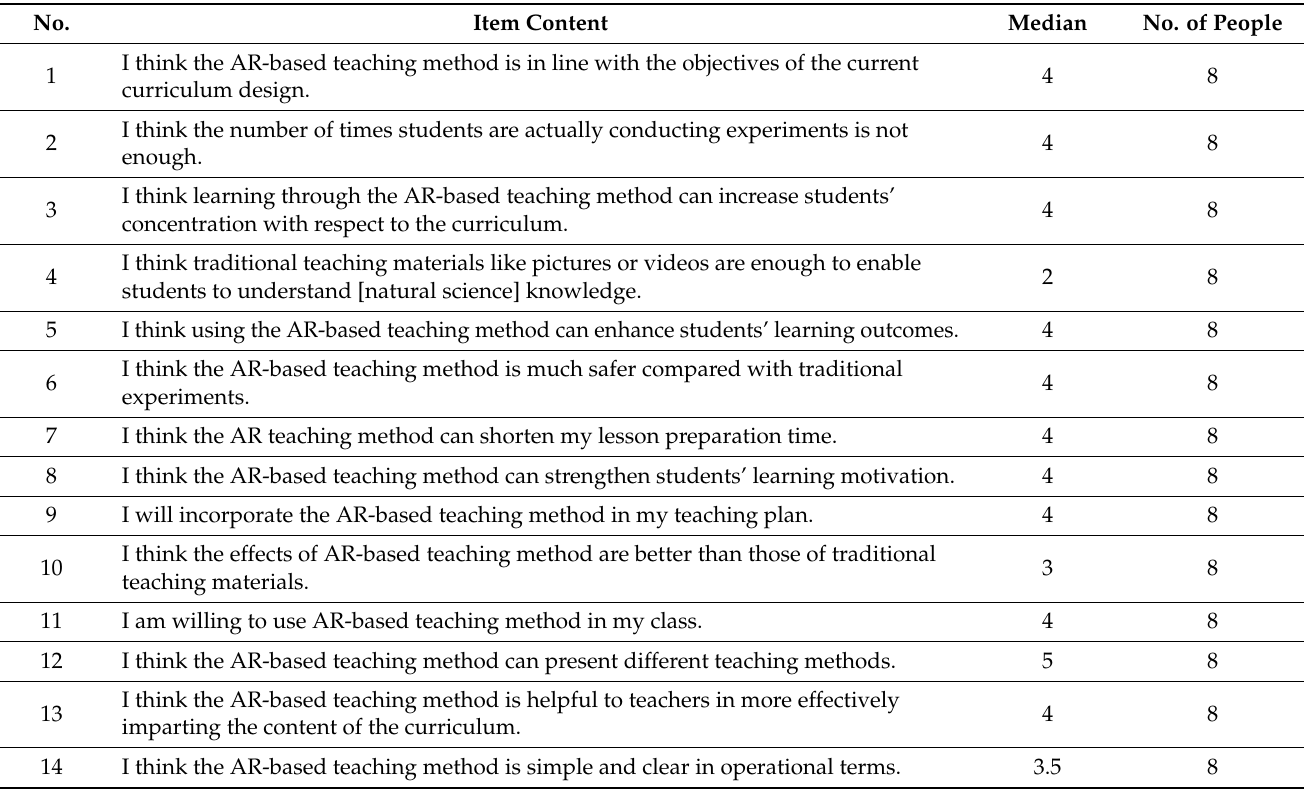
Table 13. Teacher opinions